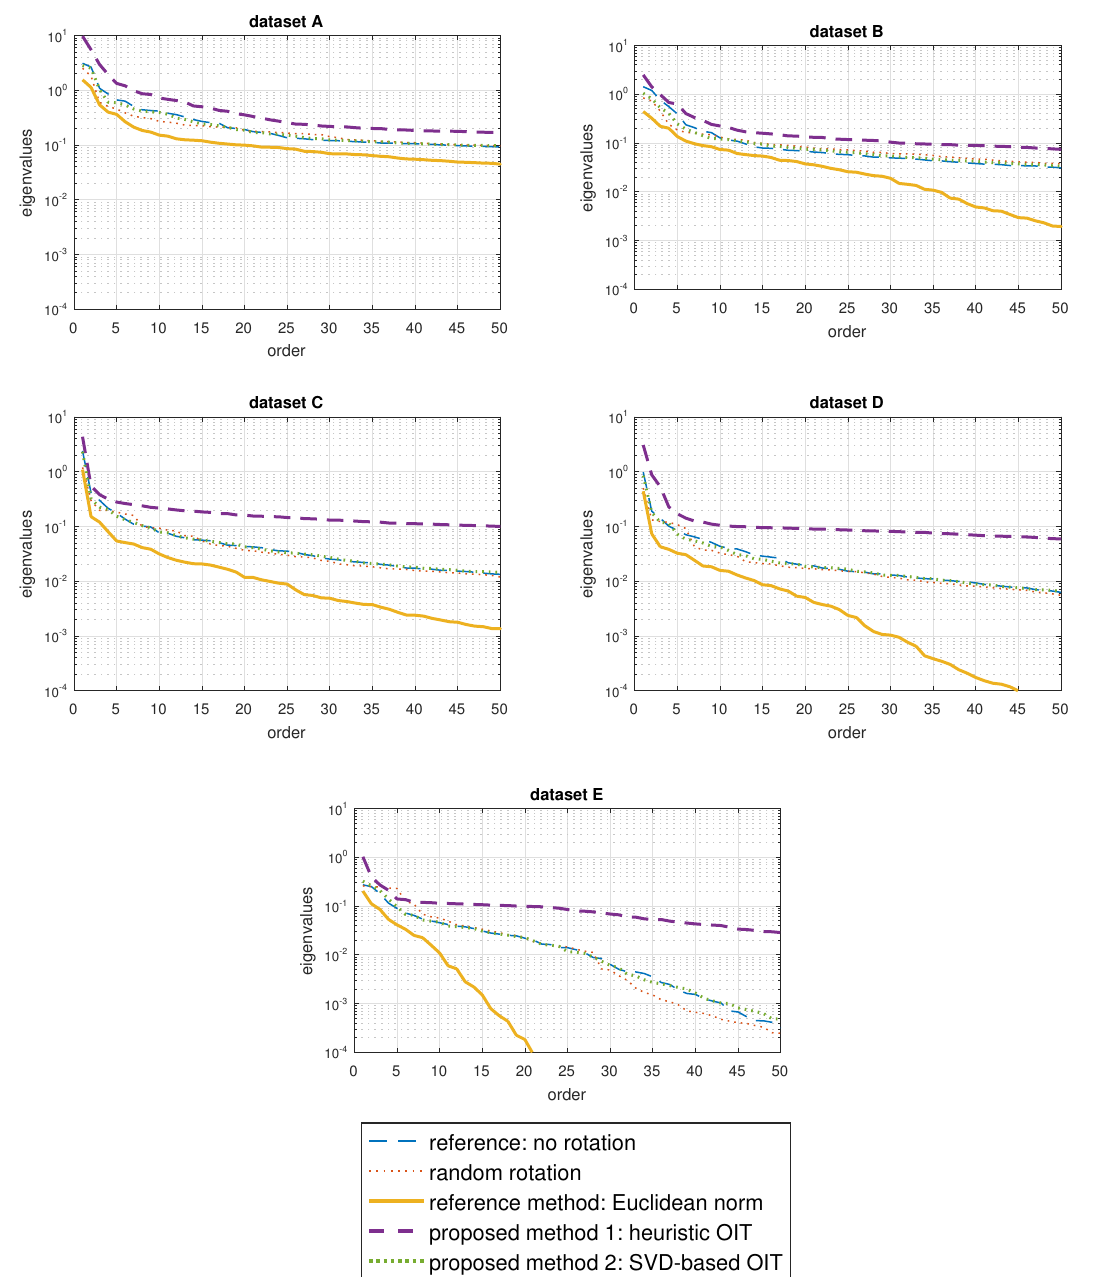
Figure 6. The first 50 eigenvalues of the covariance matrix in descending order for the features extracted from the data transformed according to the five